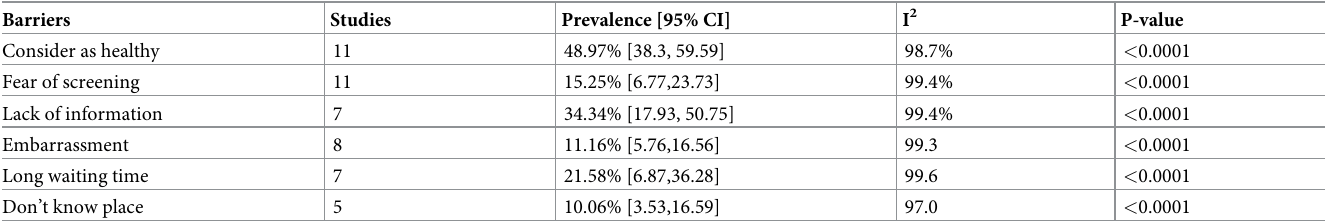
Table 3. Barriers of the cervical cancer screening utilization in Ethiopia: A